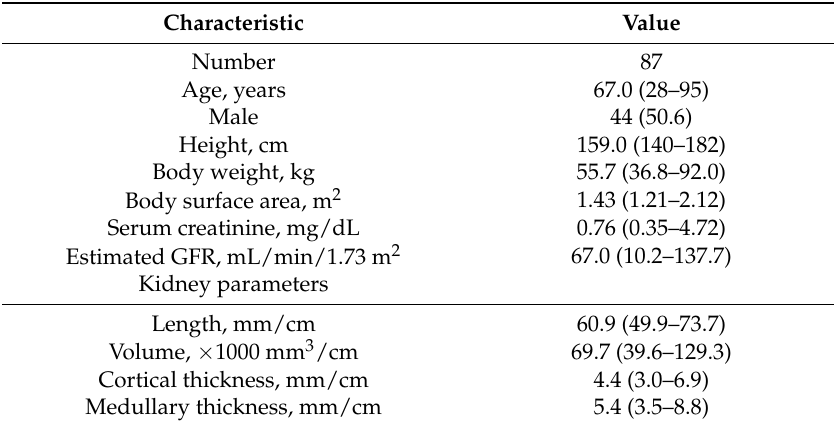
Table 1. Patient's characteristics at baseline.